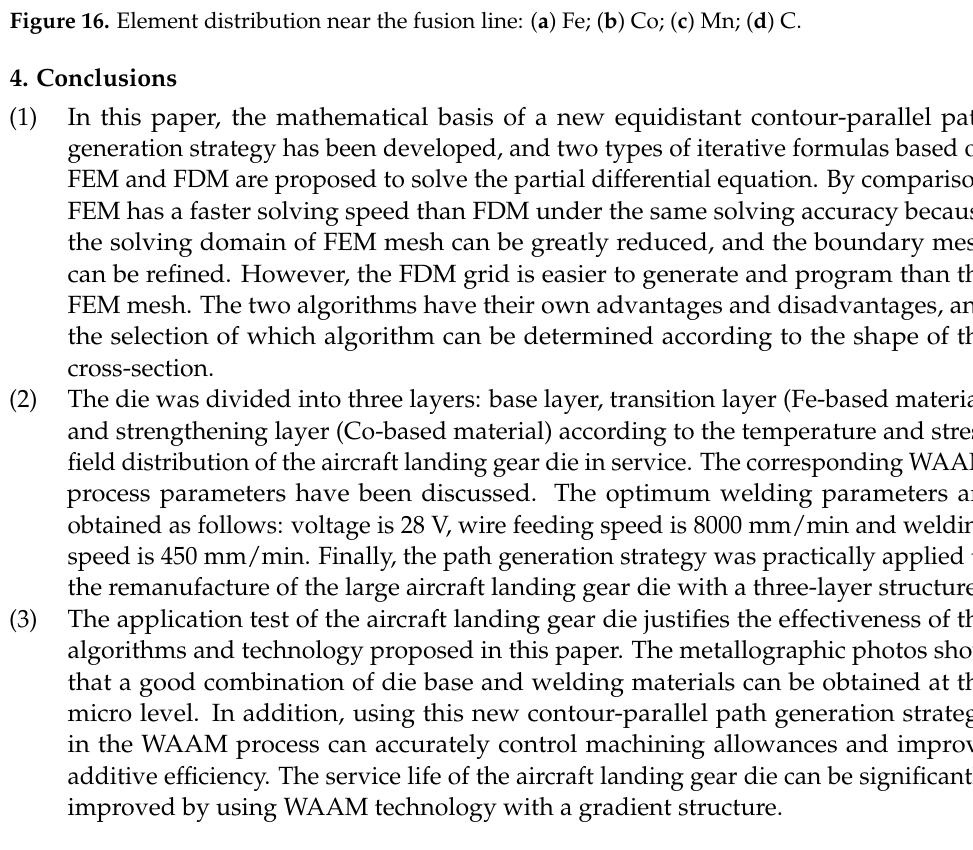
( b ) Figure 14. Appearance of traditional homogeneous die and repaired die with gradient structure: ( a ) Appearance of traditional homogeneous die after forging twice; ( b ) Appearance of gradient struc- ture die after forging 20 times. As shown in Figure 15, the fusion effect between the transition layer and the welding strengthening layer is good, and the microstructure presents a certain transition structure. The grain size gradually increases from the die base to the fusion line. This indicates that the heat input of the welding influences the grain size of the previous layer. In addition, the weld dendrites (Figure 12) near the fusion line are transformed into equiaxed crystals (Figure 16) after heat treatment. This fusion line indicates that the mechanical properties between the transition layer and the strengthening layer are well combined. The element distribution near the fusion line is shown in Figure 16. Due to the inconsistent composi- tion, the fusion effect between welding material and base metal needs to be considered in the welding process. Cobalt and iron permeate each other around the fusion line. This shows that the base metal and welding material can be fully integrated into the welding process.